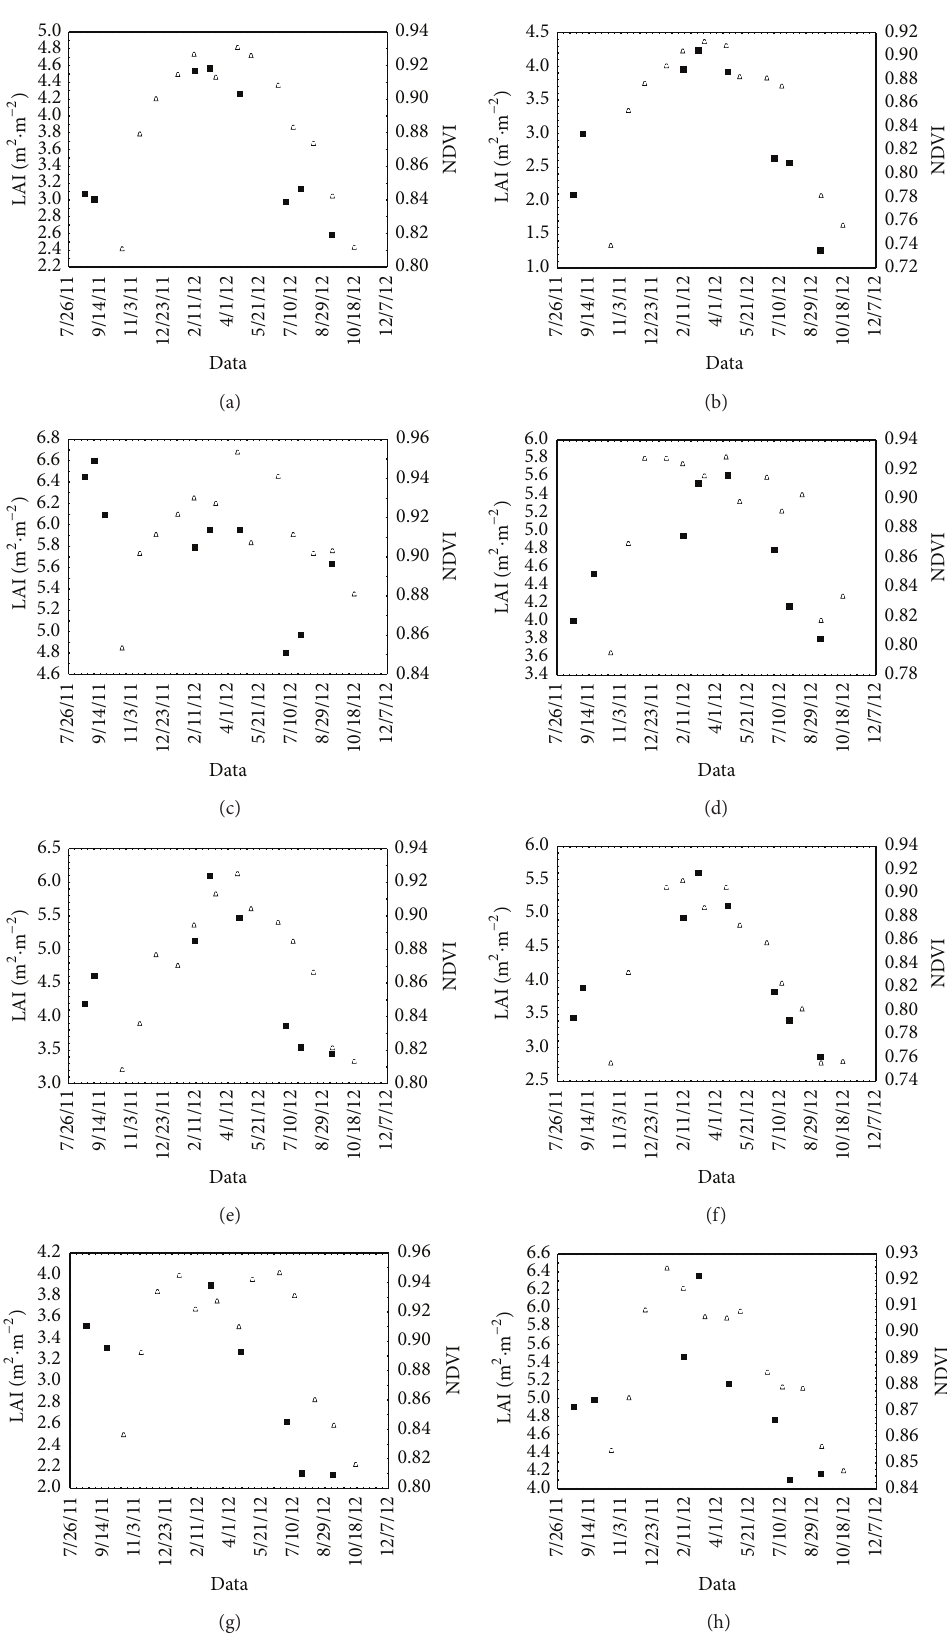
Figure 3: Relations between LAI (m 2 ⋅ m −2 ) and NDVI for the